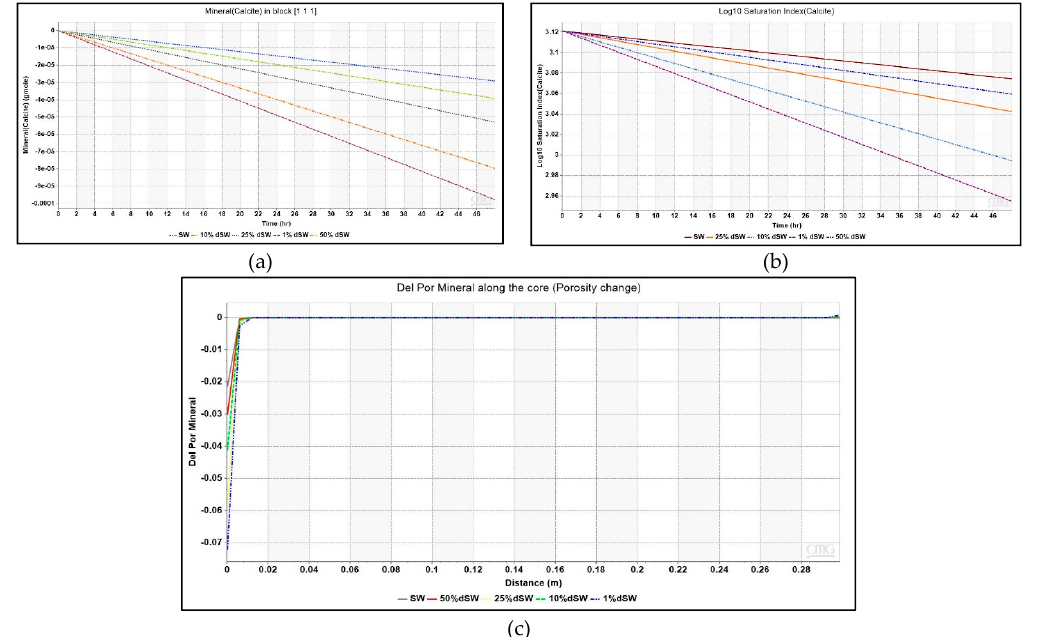
Figure 8. (a) Mineral moles of calcite for various brines as a function of injection time, (b) Saturation index for various diluted brines as a function of injection time for injection block – {1 1 1}, and (c) Change in porosity given by the parameter – Del Por Mineral due to mineral deposition against lateral distance along the core.